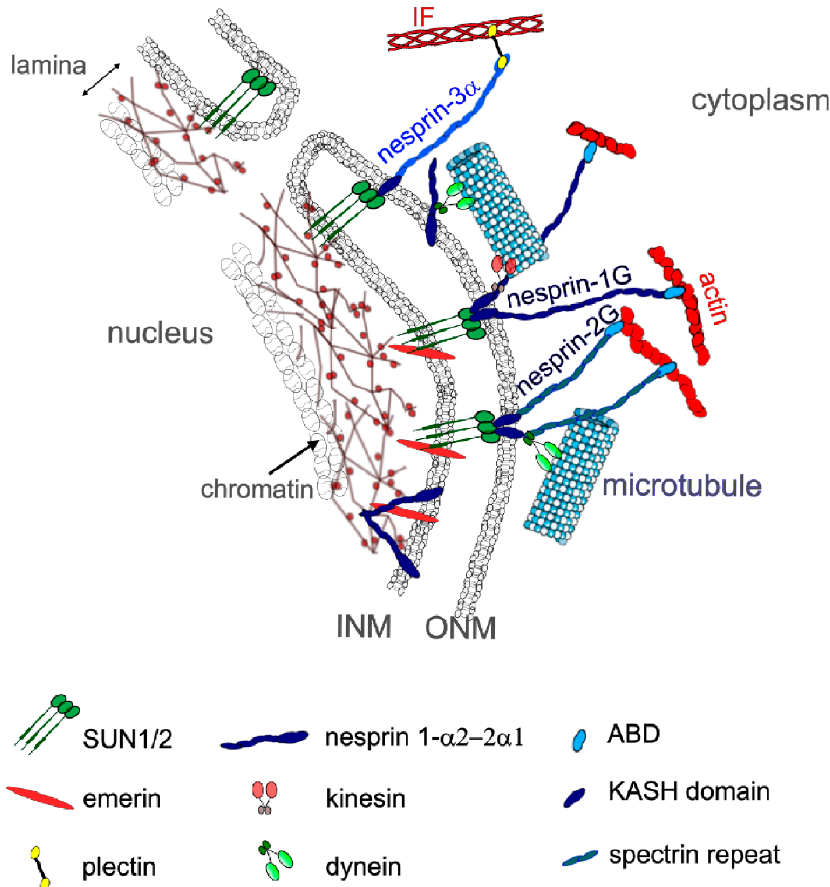
Figure 3. LINC complexes in skeletal muscle. LINC is a complex of proteins including SUN1/2 and nesprins that connect the cytoskeleton to the nucleoskeleton. Different nesprin isoforms are expressed during myogenesis: in MCPs, nesprin-1G and -2G can interact with actin and microtubules in the cytoplasm and with SUN1/2 proteins, emerin and lamins, on the inner nuclear membrane. Shorter nesprin-1 α 2 and nesprin-2 α 1 are expressed during myotube differentiation and can bind with microtubules in the cytoplasm via kinesin and other proteins such as A-kinase anchoring protein. Short nesprin-1 α 2 can also interact with intranuclear proteins such as lamins and emerin. INN: inner nuclear membrane; ONM: outer nuclear membrane. In contrast to SUN proteins, nesprins-1 and -2 switch localizations and isoforms dur-